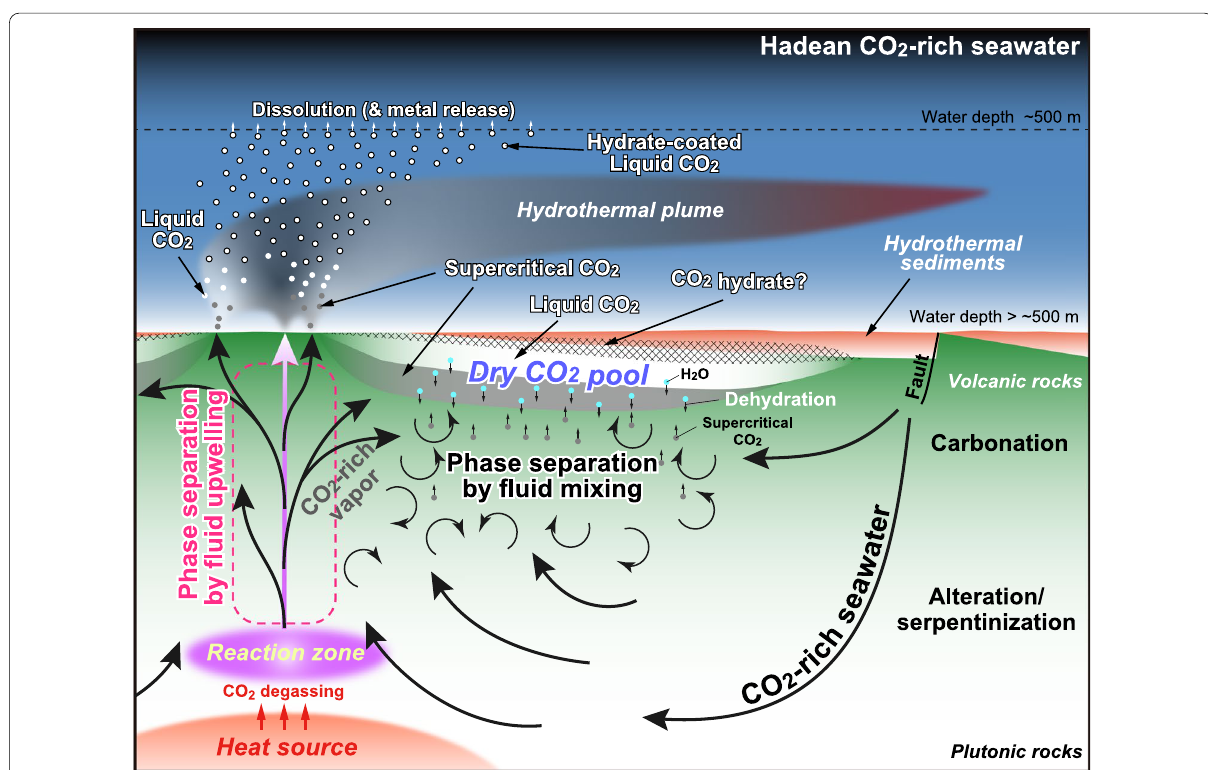
Fig. 4 Schematic of Hadean seafloor hydrothermal systems bearing a L/SC-CO 2 pool. The CO 2 -rich seawater infiltrates the subseafloor volcanic rocks and reacts with basalts or komatiites, causing carbonation and alteration of basalts or serpentinization of komatiites in the seawater recharge zones. When hydrothermal fluid reaches the reaction zone, it receives abundant degassed CO 2 from an underlying magmatic heat source. During fluid upwelling, phase separation of the CO 2 -rich hydrothermal fluid progressively occurs through depressurization, which likely condenses the CO 2 in the vapor phase. If the CO 2 -rich vapor phase is physically segregated from the main flow channel of the upwelling brine phase, it is continuously mixed with recharged seawater and/or cooler pore fluid, causing further phase separation by the temperature decrease. CO 2 is then purified in vapor phase. Eventually, these condensation and purification processes generate many SC-CO 2 droplets beneath the seafloor. The SC-CO 2 is less dense than seawater and migrates upward. As it cools during the upward migration, its phase converts to L-CO 2 . These processes form a large L/ SC-CO 2 pool beneath the seafloor. If the temperature of the bottom seawater is lower than approximately 10 °C, reactions between L-CO 2 and the ambient seawater/pore fluid requisitely generate solid CO 2 hydrates that cement the pores, voids and cavities of the hydrothermal sediments and permeable volcanics. This self-sealing effect by CO 2 hydrates prevents the leakage of L/SC-CO 2 through the seafloor. In contrast, when CO 2 hydrates are absent in the vicinity of warm/hot hydrothermal vents, L/SC-CO 2 leaks from the inner edge of the pool and enters the upwelling hydrothermal fluid just below the seafloor, where it is emitted in the form of bubbles. L-CO 2 containing these bubbles transforms to hydrate-coated L-CO 2 during upward migration through the water column. The bubbles disappear at depths around 500 m because L-CO 2 and CO 2 hydrate are unstable at these depths. Eventually, both CO 2 gas and the organic molecules dissolved in L/SC-CO 2 are released to the ambient seawater. If the hydrothermal vents are black-smoker type, the L-CO 2 bubbles will carry heavy metals upward to the shallower part of the water